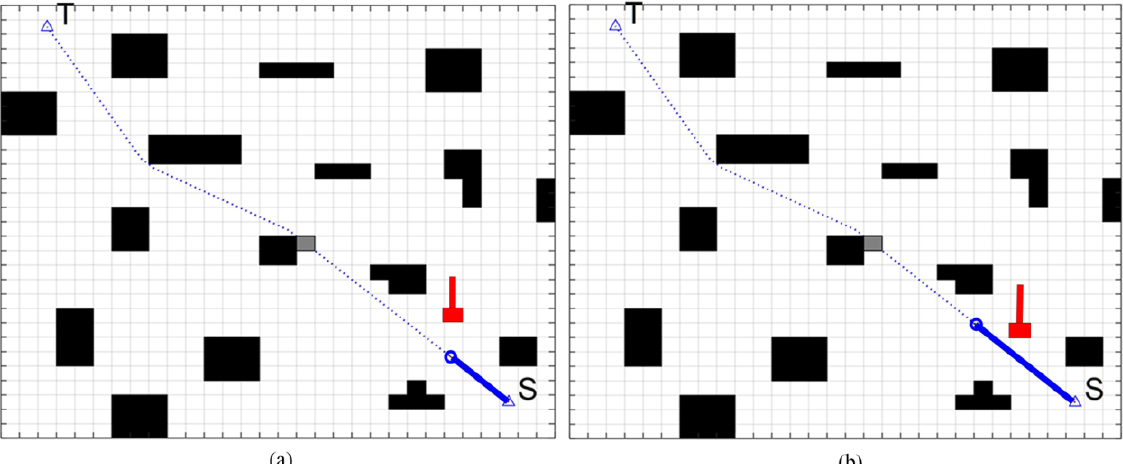
Figure 13. Dynamic obstacles for low-speed movement. ( a ) There is an unknown low -speed dy- namic obstacle in front of the FAGV and it is predicted that the FAGV will not collide with the obstacle. ( b ) FAGV continues on the current path. When FAGV travels to the intersection point of the track, the obstacle is still not reached.